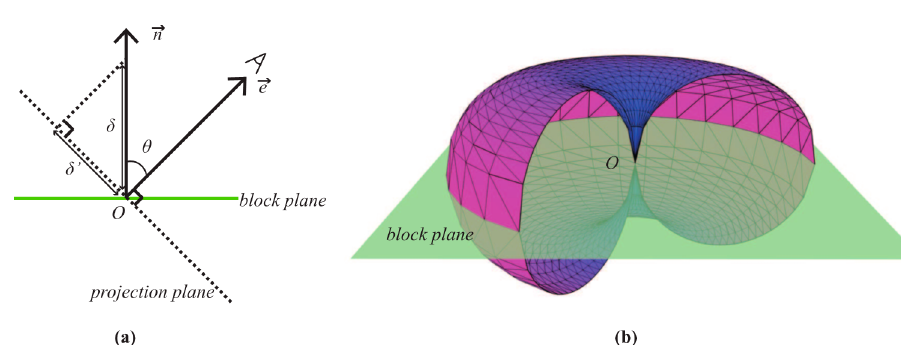
Figure 9. Computation of screen-space error 𝜌 .